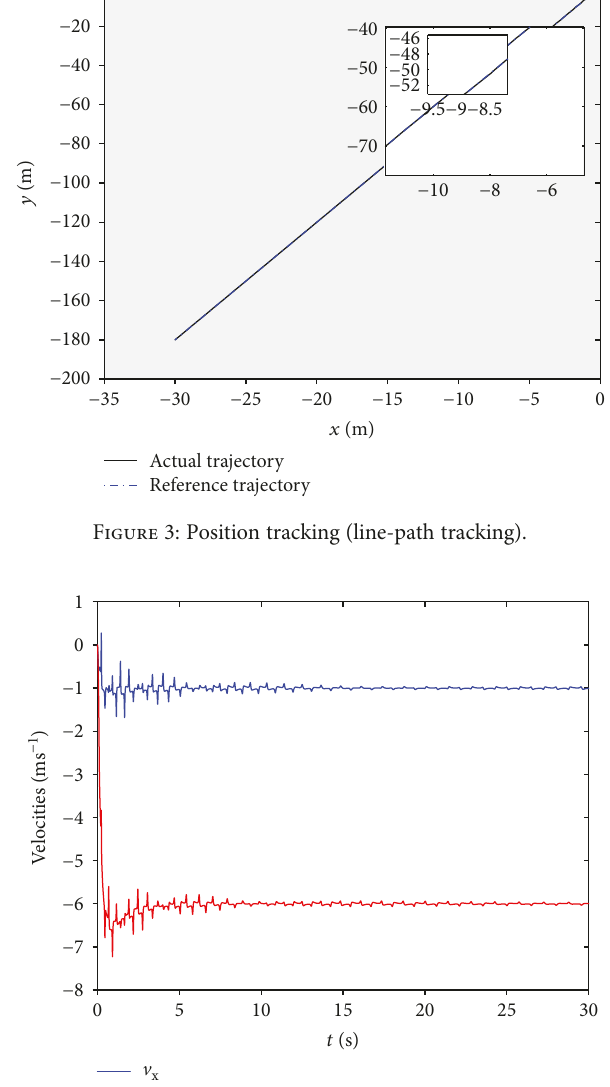
Table 1: Physical parameters of the robotic fi sh.